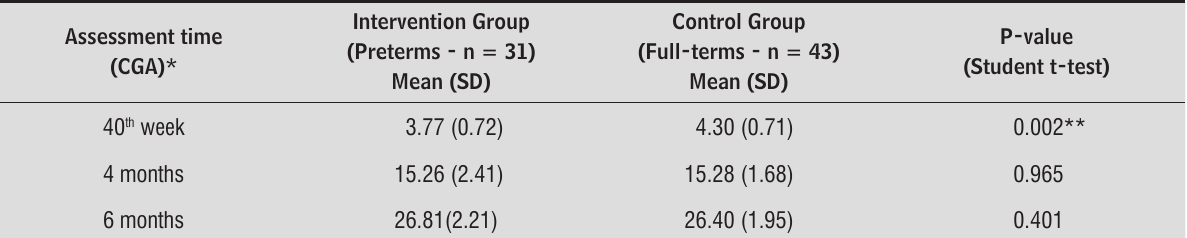
Table 2 - Scores for assessment of neuromotor development by AIMS in preterm and full-term newborns; Montes